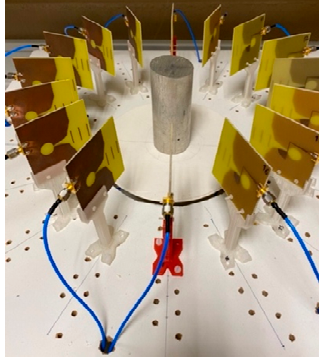
Figure 6. Calibration measurement with a metallic cylinder.